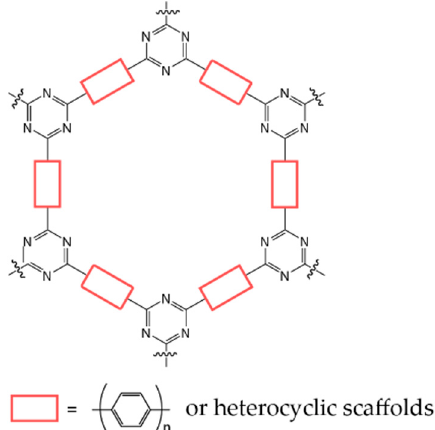
Figure 1. Sketch of the structure of covalent triazine-based frameworks.